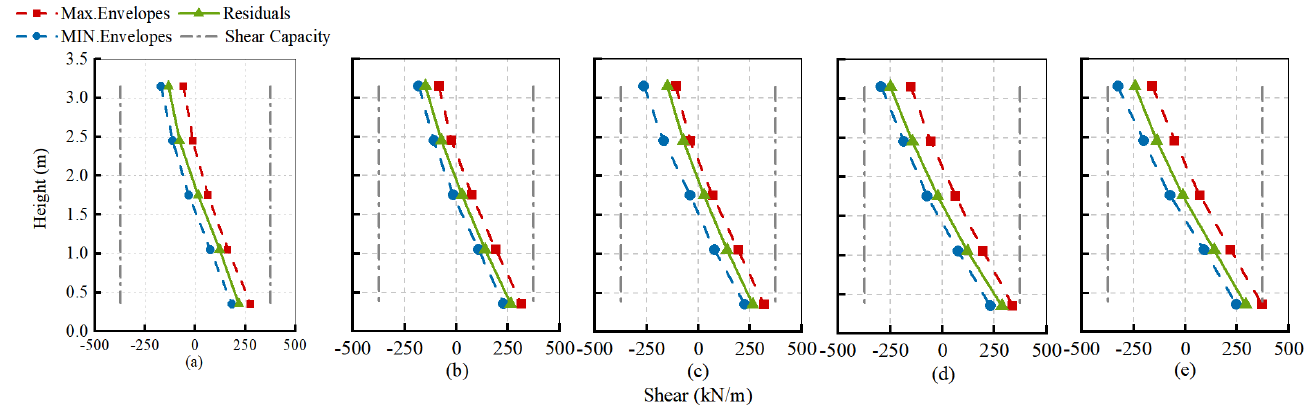
Figure 13. Maximum and minimum envelopes, residual values, and design capacity value of the left wall shear force distribution during the earthquake, the data in ( a ), ( b ), ( c ), ( d ), and ( e ) are from numerical models for 2 m, 2.5 m, 3 m, 3.5 m and 4 m burial depths, respectively.